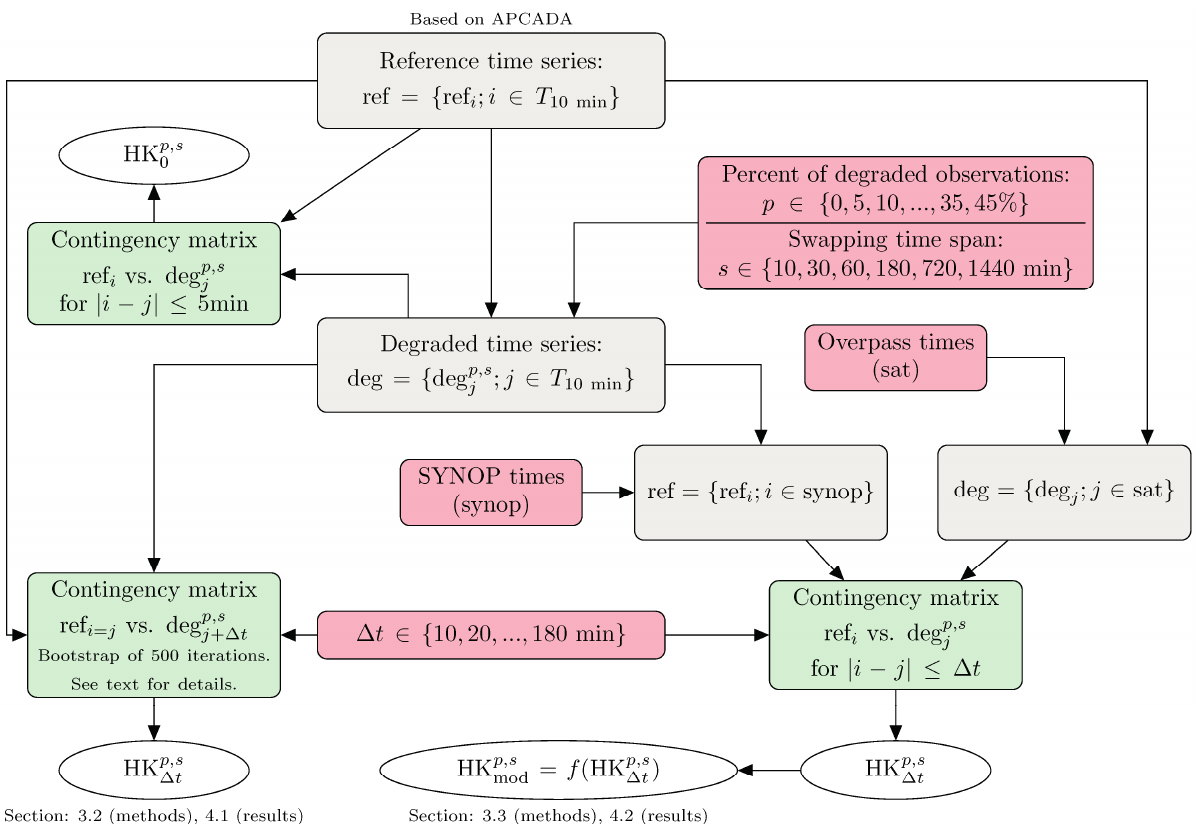
Figure 2. Flowchart of the analysis performed in this study. The boxes represent: time series (grey), time settings used in the analysis (red) and contingency matrices (green). The ellipses indicate cloud cover skill scores. See text for